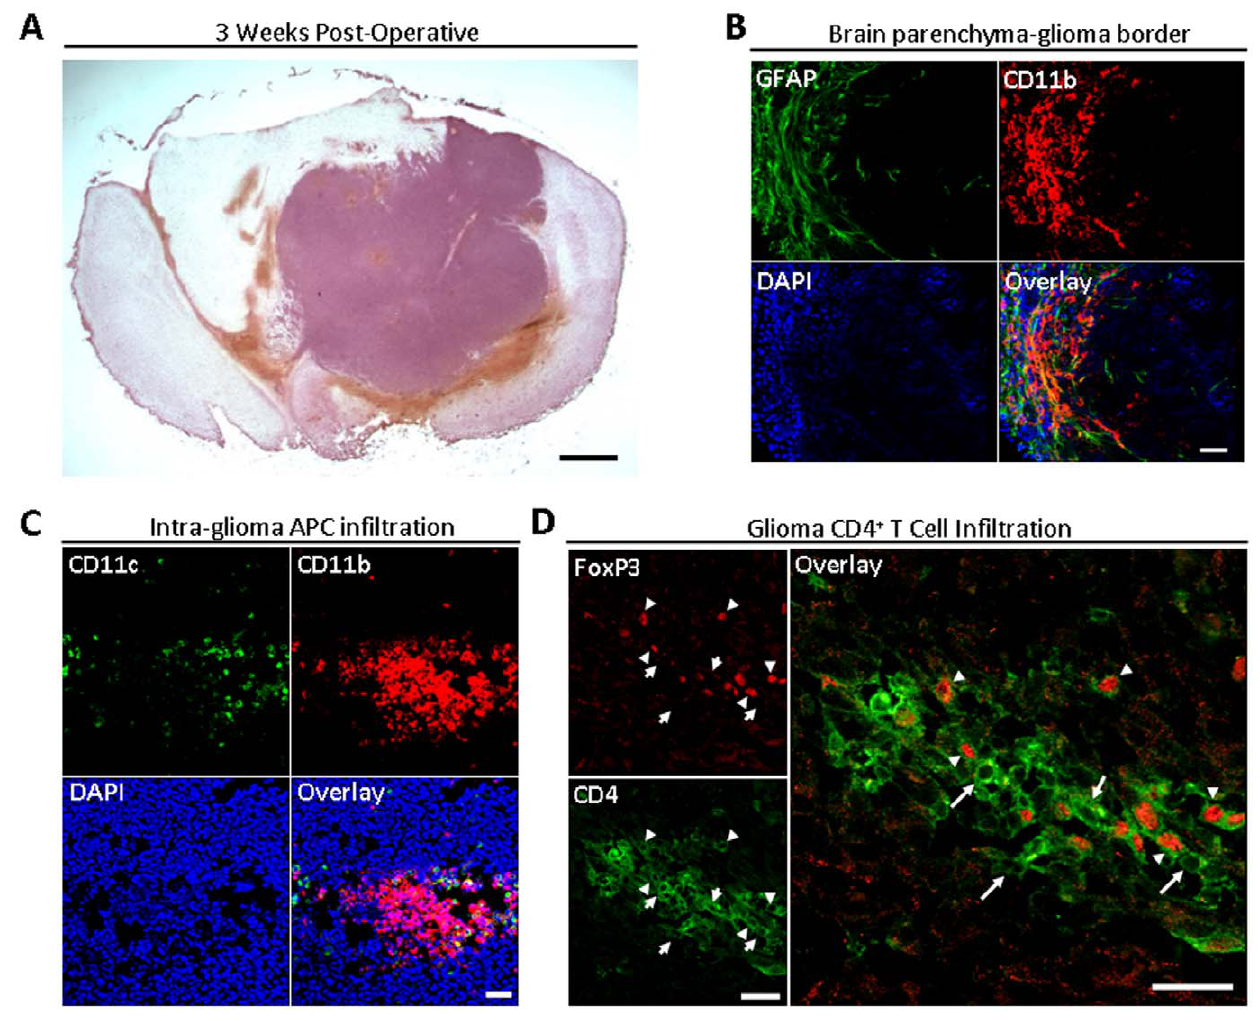
Figure 1. A mouse brain that received an intracranial injection of GL261 cells. At three weeks post-operatively. (A) Hematoxylin and eosin staining of mouse glioma at 3 weeks post-operatively. Scale bar =1 mm. (B) GFAP (green), CD11b (red) and DAPI (blue) immunofluorescence along the border between mouse brain parenchyma and glioma. Scale bar =50 m M. (C) CD11c (green), CD11b (red), and DAPI (blue) immunofluorescence in the mouse glioma. Scale bar =50 m M. (D) CD4 (green) and FoxP3 (red) immunofluorescence in the mouse glioma. Tailed arrows indicate CD4 + FoxP3 2 cells, while untailed arrows indicate CD4 + FoxP3 + T regulatory cells. Scale bar =25 m M. doi:10.1371/journal.pone.0015390.g001 PLoS ONE |